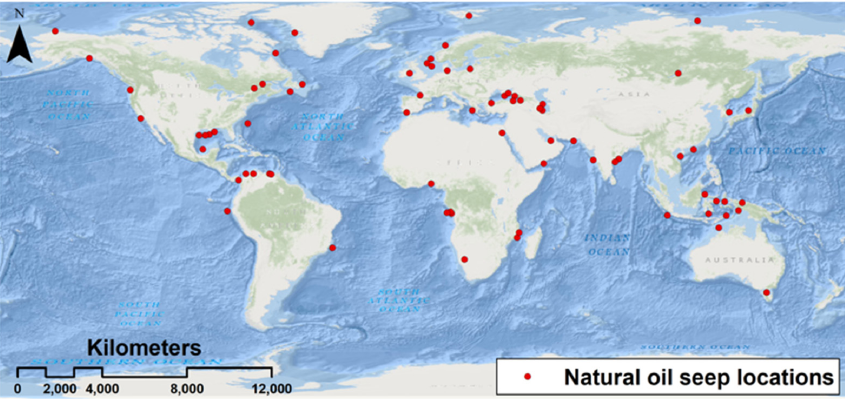
Figure 1. Generalized locations of well-documented natural oil seeps. Table 1. Example references documenting geologic features of known oil seeps. Corresponds with seep locations in Figure